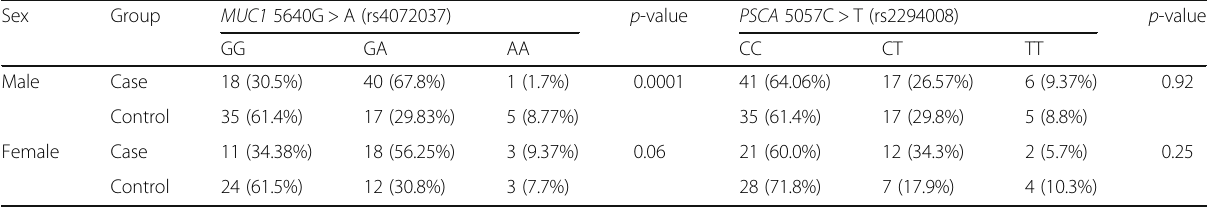
Table 6 Distribution of genotypes MUC1 (rs4072037) and PSCA (rs2294008) polymorphisms according to